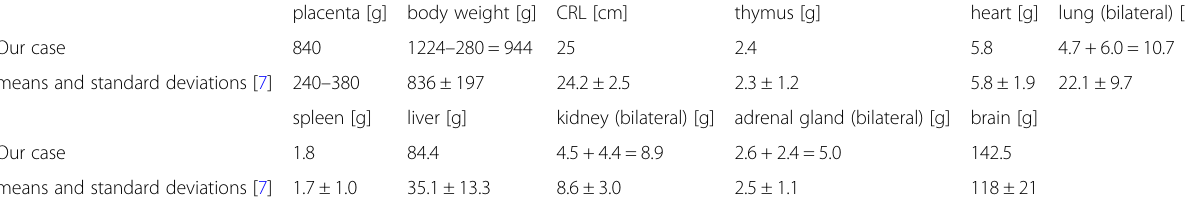
Table 2 Organ weights of the fetus with means and standard deviations